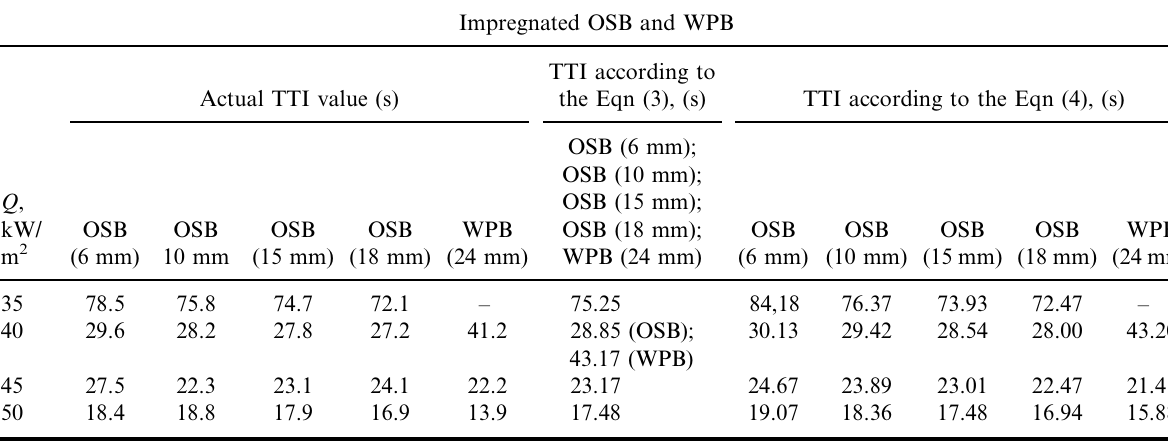
Table 6. Actual and forecasted values of TTI for impregnated OSB and WPB Impregnated OSB and